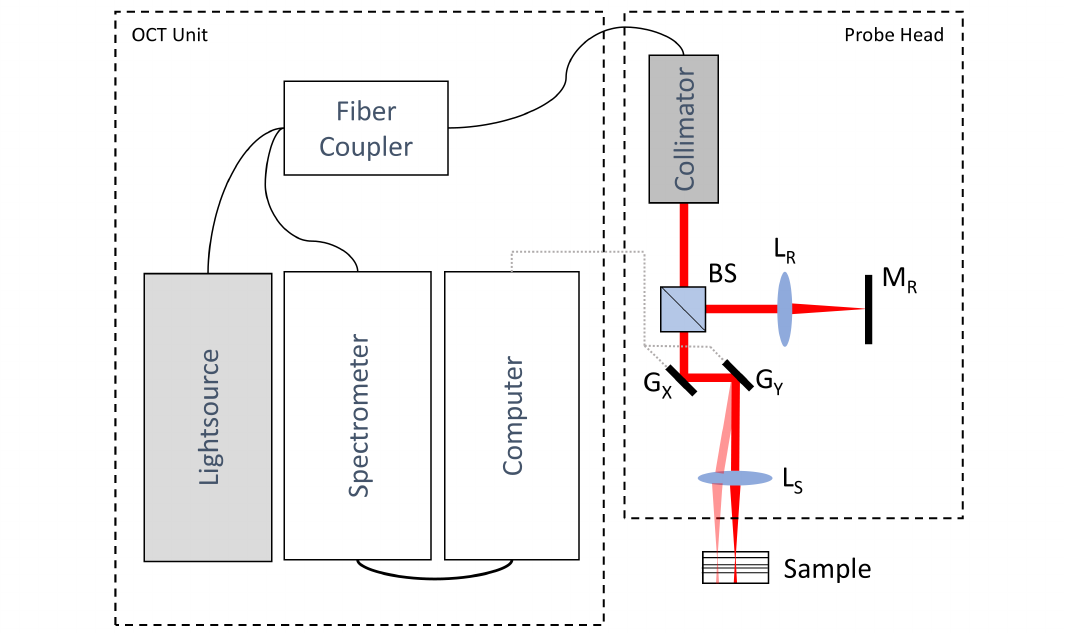
Figure 2. Principle of SD-OCT: Broadband light is sent through a fiber coupler to the probe head. Inside the probe head, the light is collimated and sent through a Michelson interferometer, which divides the collimated beam into sample and reference beams. The sample beam is focused and scanned over the sample under testing along two directions. The reflected light interferes with the reference beam. A spectrometer detects the so-called interferogram, which then is sent to the computer for further data processing. The parts included in the probe head are the beamsplitter (BS), reference path lens (L R ), reference mirror (M R ), galvano mirrors for the x and y directions (G X , G Y ) abd focusing lens (L S